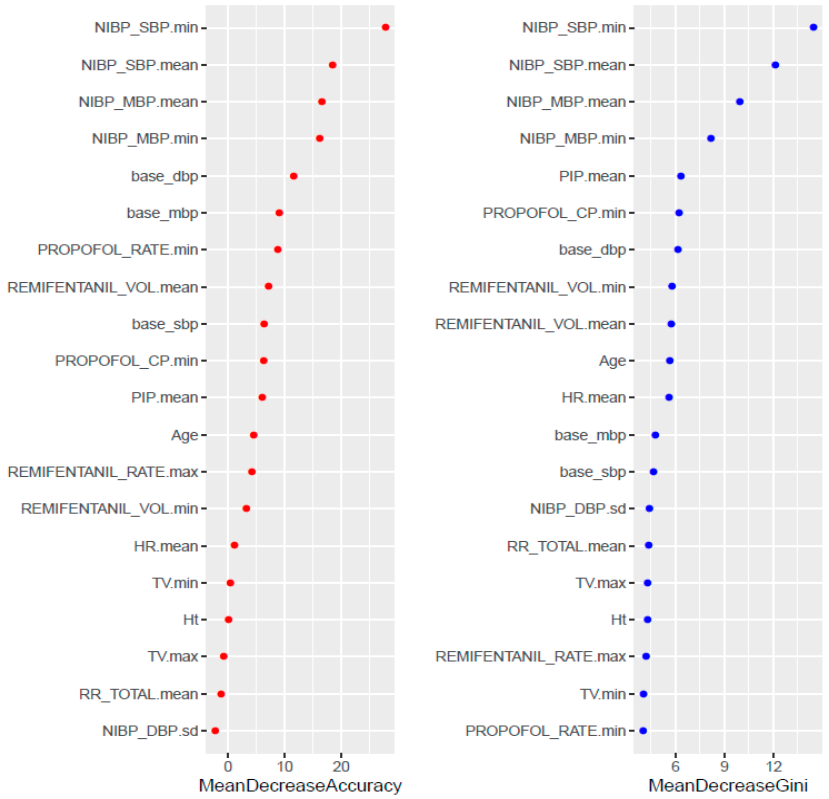
Figure 6. Feature importance.